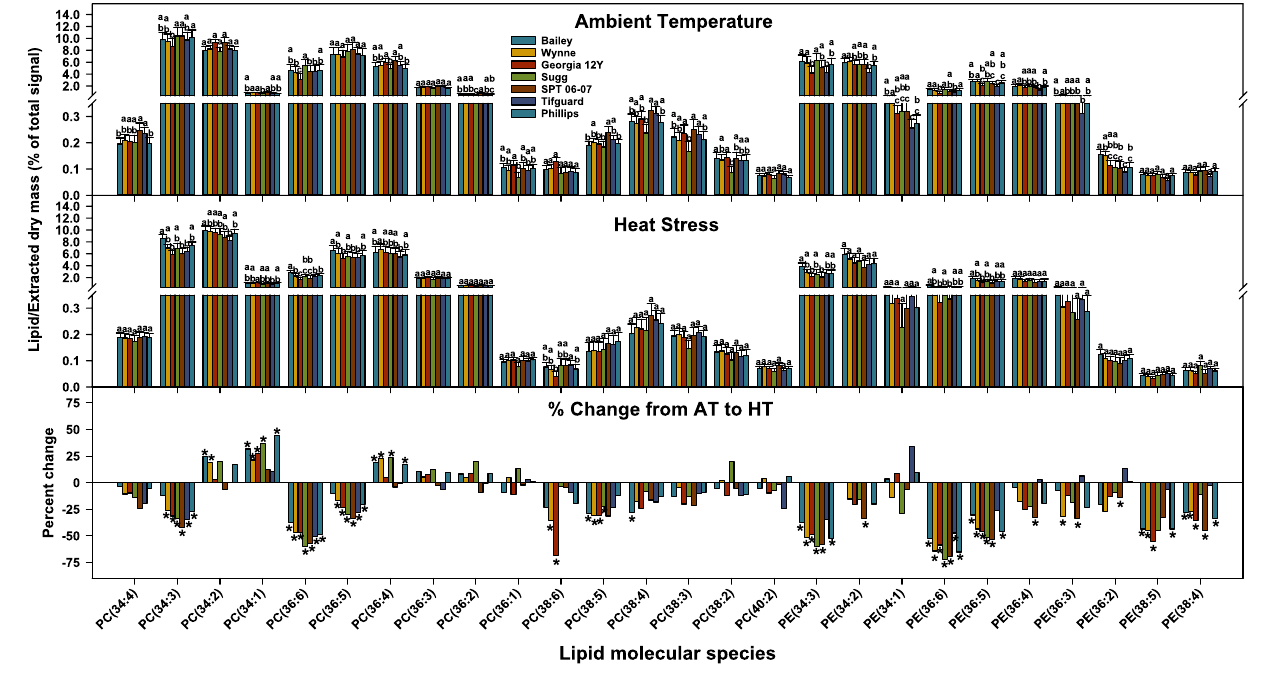
Figure 4. Changes in the amount of phosphatidylcholine (PC) and phosphatidylethanolamine (PE) molecular species, as percentage of total mass spectral signal, in peanut anthers in response to heat stress. Lipid species shown were those that passed both the limit of detection (LOD > 0.0005 nmol) and coefficient of variation (CoV < 0.3) cutoffs (see “Materials and methods” for more details). Values shown are least-squares means. Error bars represent standard errors about the least-squares mean of 16 observations (2 years × 2 blocks × 4 replications) except for Sugg and SPT 06-07, which have 8 observations (1 year × 2 blocks × 4 replications). Least-squares means with different letters are significantly different according to Fisher’s least significant difference (LSD) test at α = 0.05. An asterisk (*) above bars indicate a significant difference at α = 0.05 between AT and HT for that genotype. AT, ambient temperature (31/22 °C for 2018 and 28/22 °C for 2019; average day/ night temperatures during the 17-days and 18-days treatment periods in 2018 and 2019, respectively); HT, high temperature (41/27 °C for 2018 and 38/26 °C for 2019). Lipid molecular species are identified as total acyl carbons: total double bonds. Breaks on the y axis indicate a change in scale. Data from 2 years (2018 and 2019) were pooled together for